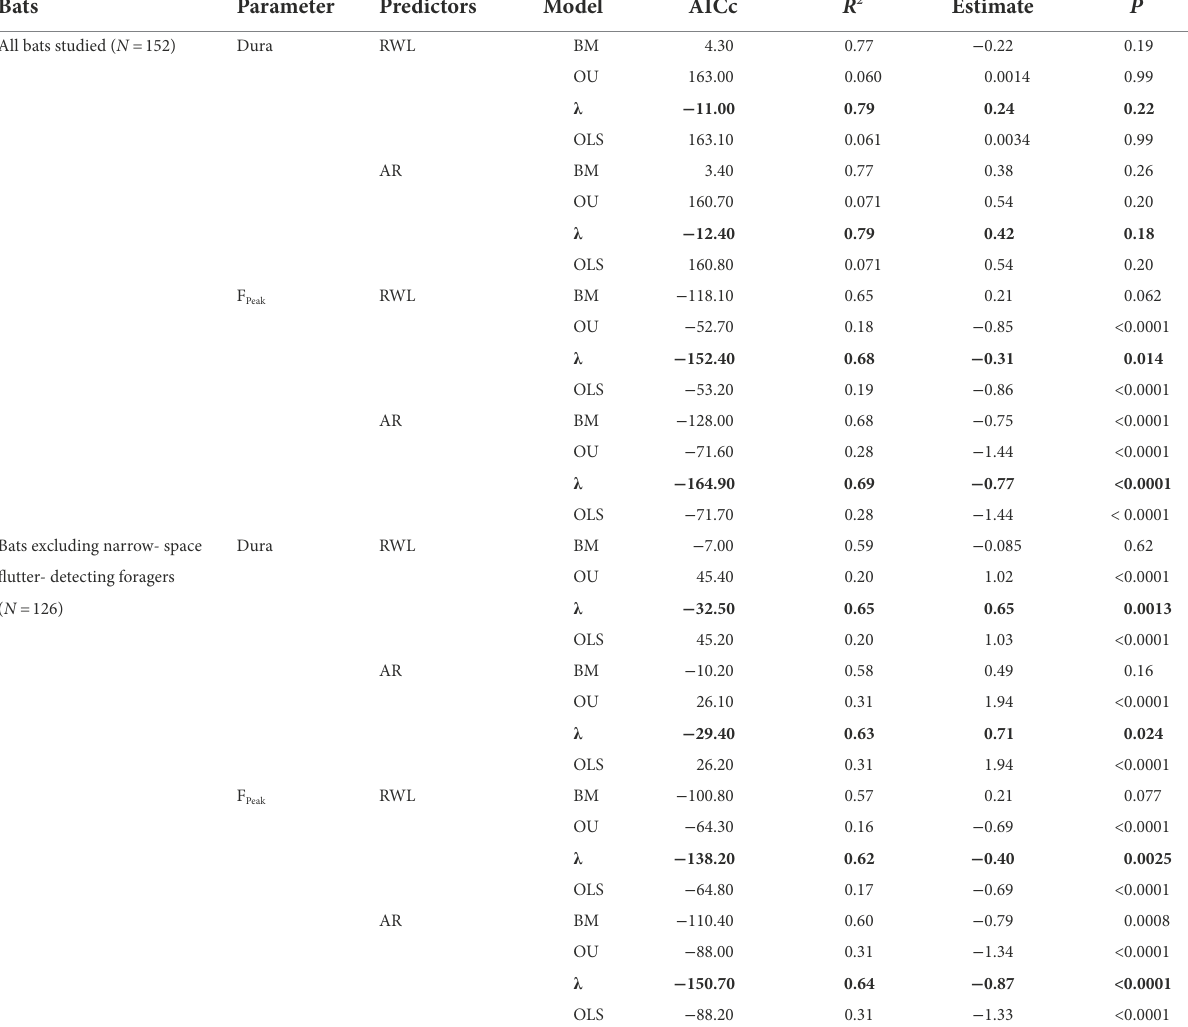
TABLE 1 Summary of regression models under different evolutionary